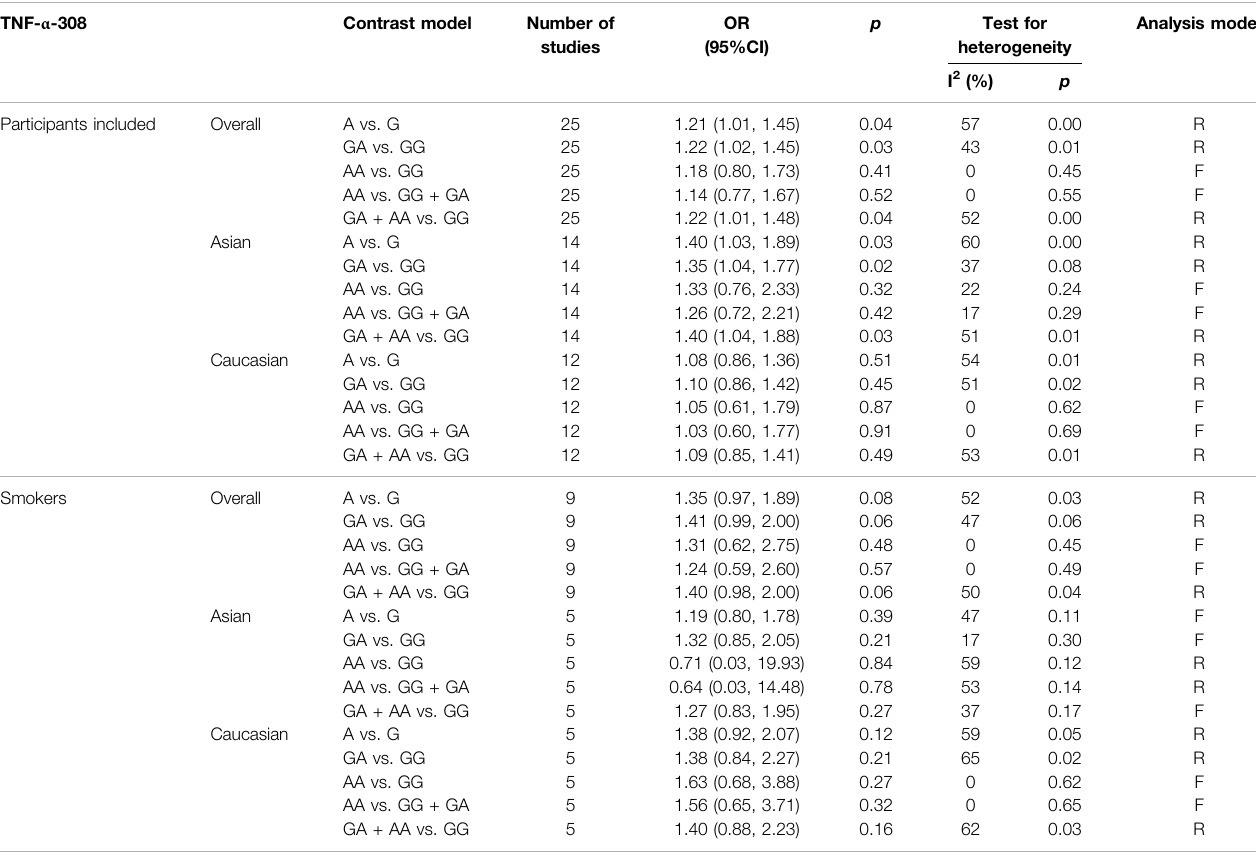
TABLE 2 | Meta-analysis results for relationship between the TNF- α -308 polymorphism and COPD risk.; Abbreviation: CI (cid:1) con fi dence interval, F (cid:1) fi xed effect model, OR (cid:1) odds ratio, R (cid:1) random-effect model. TNF- α -308 Contrast model Number of